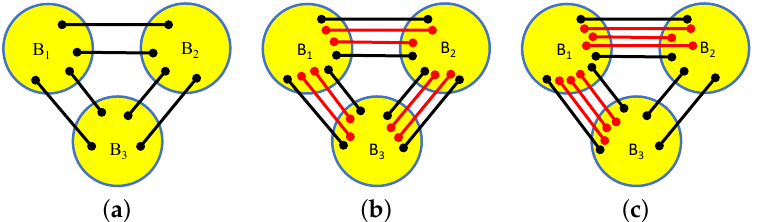
Figure 53. An isostatic body-bar graph for the plane ( a ) has several cones to 3-space. In ( b ) we have just inserted three spanning trees (in red). In ( c ) we have added the new point O to B 1 and then split it to create the added 3 red spanning